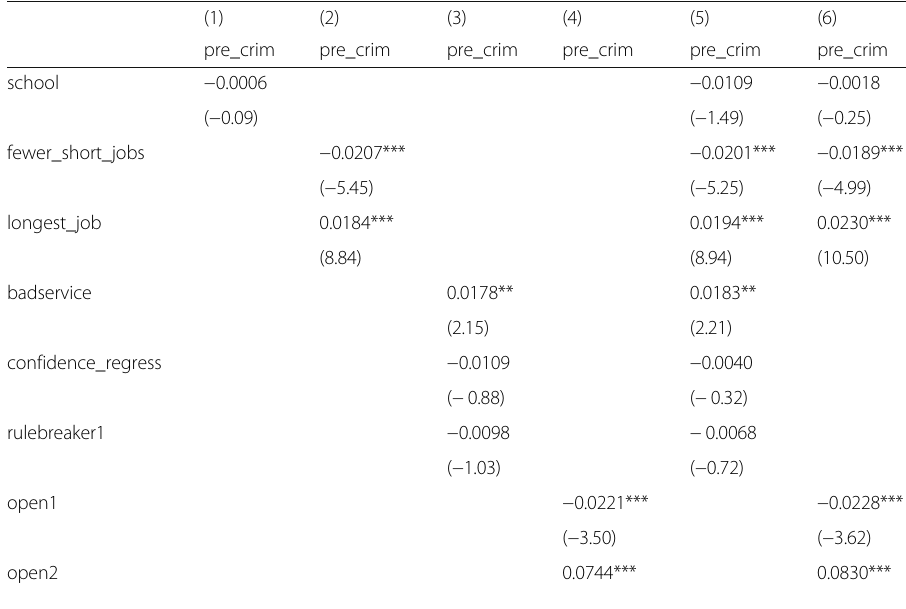
Table 14 Question-level correlates of criminal background in hired population (all